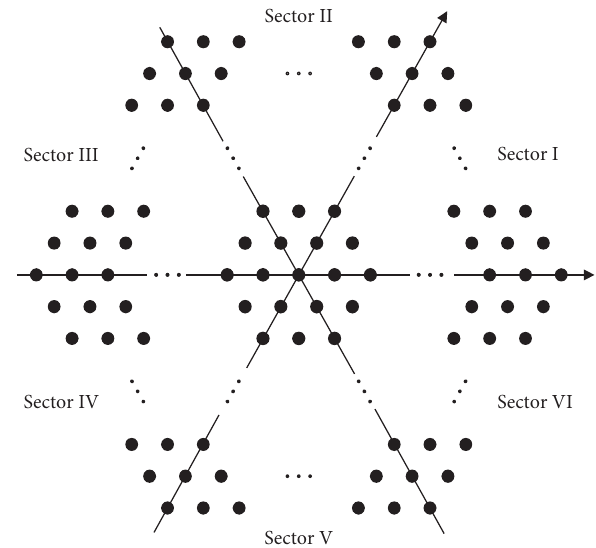
Figure 2: Space vector of